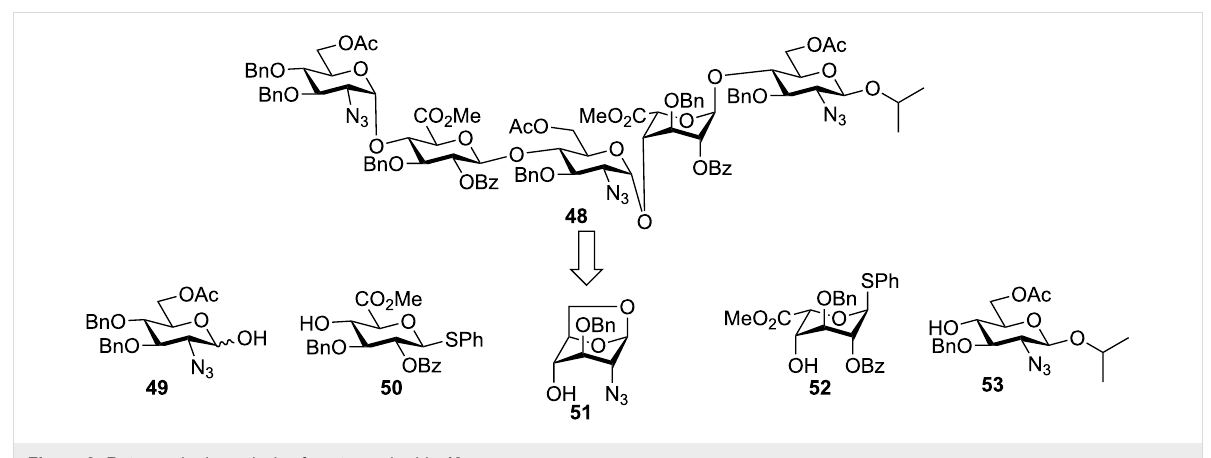
Figure 2: Retrosynthetic analysis of pentasaccharide 48